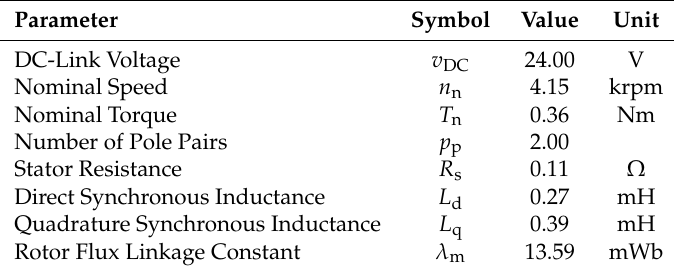
Table 1. Parameters of the test motor.